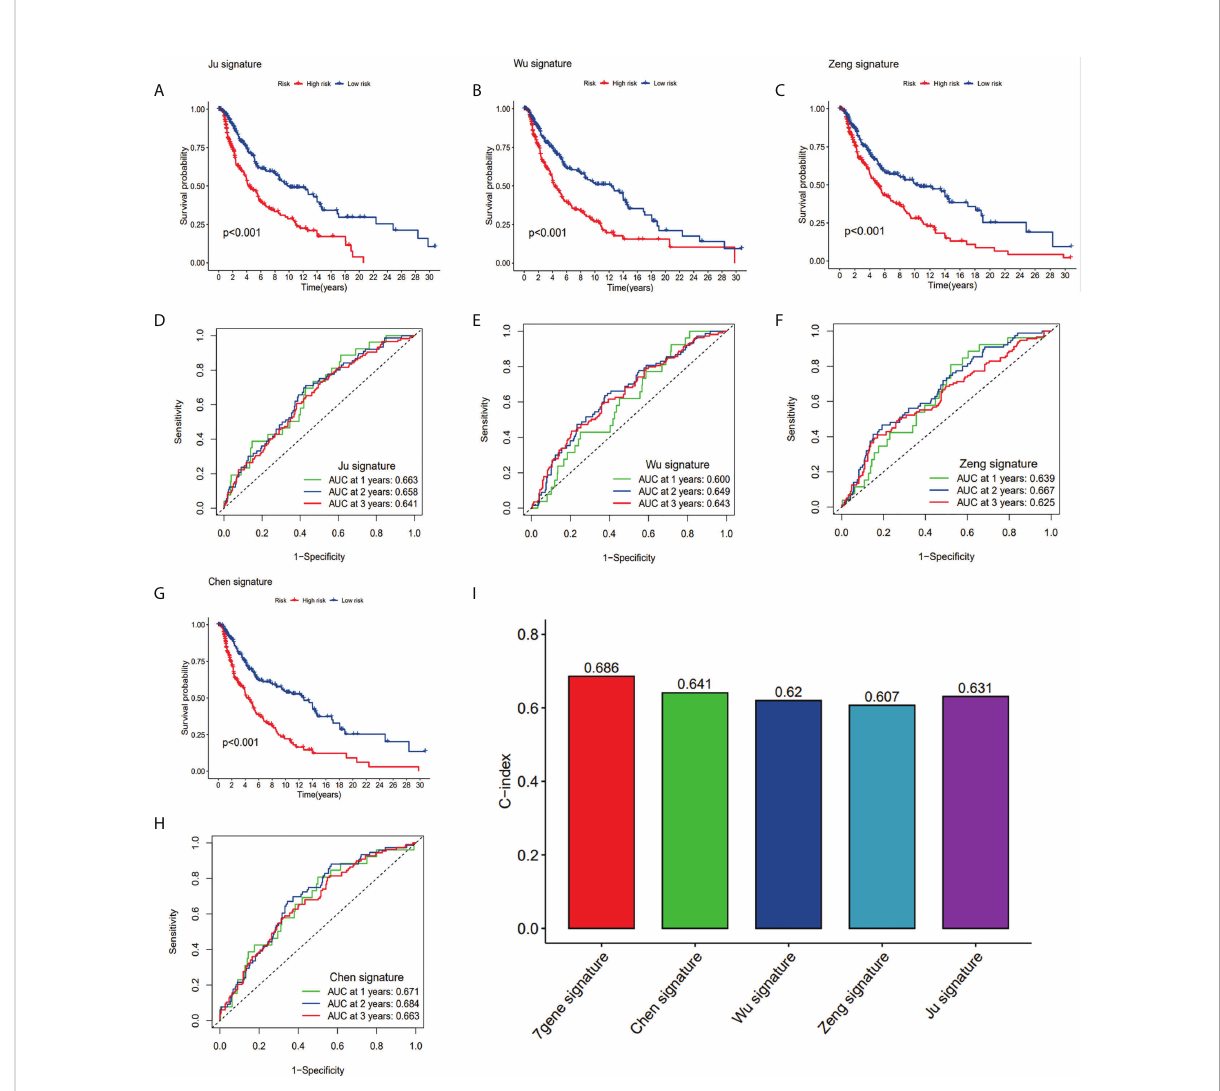
FIGURE 10 Comparison of CRG risk model with others. (A, D) The KM curves and ROC of an eight-gene (Ju) risk model. (B, E) The KM curves and ROC of a nine-gene (Wu) risk model. (C, F) The KM curves and ROC of a ten-gene (Zeng) risk model. (G, H) The KM curves and ROC of a nine-gene (Chen) risk model. (I) C-indexes of the fi ve risk